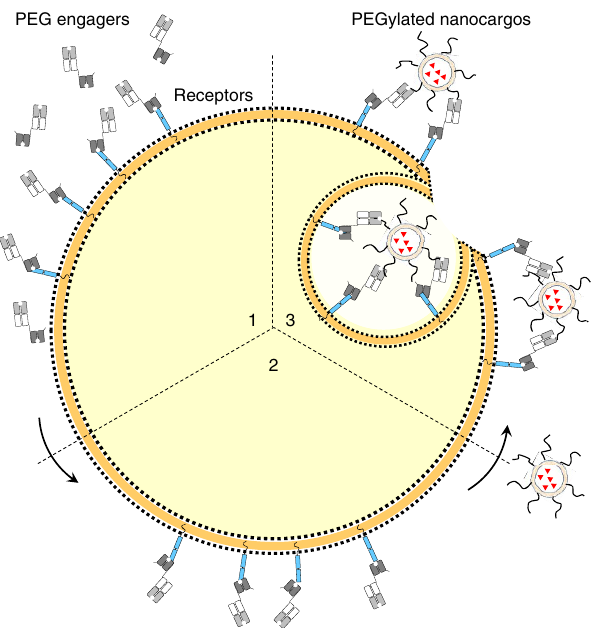
Figure 1 | Overview of PEG engager pre-targeting strategy. The pre-targeting approach relies on (1) PEG engagers (bispecific humanized anti-PEG Fab (cid:2) antitumour antigen single chain disulfide-stabilized variable fragment) binding to target cancer receptors, (2) PEG engagers remaining on the cell surface until contact with (3) PEGylated nanoparticles trigger conditional internalization into the